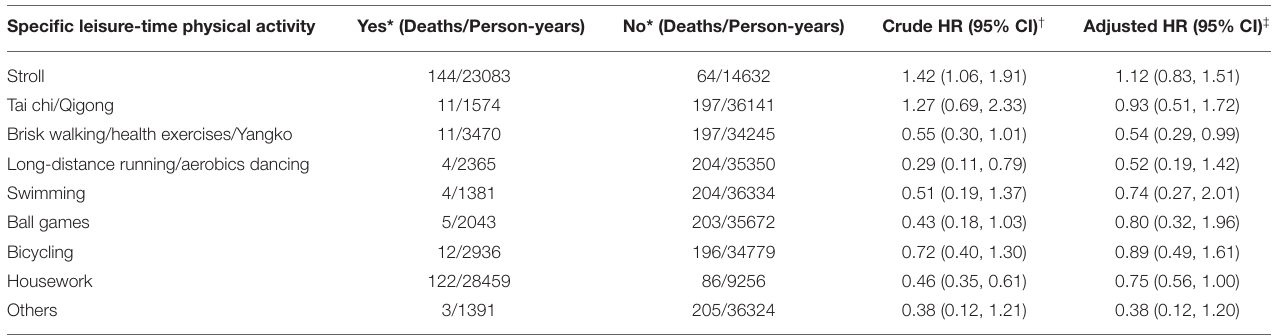
TABLE 5 | The association between specific leisure-time physical activity and the all-cause mortality risk. Specific leisure-time physical